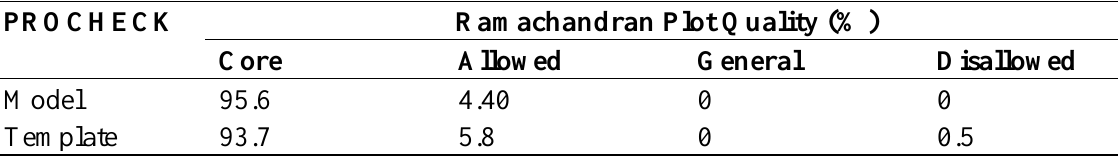
Table 1. Quality of structures checked by PROCHECK for model and